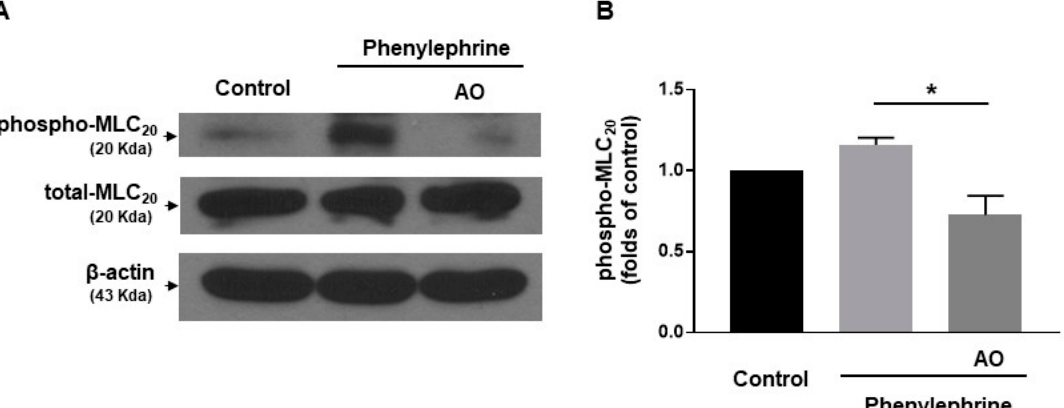
Figure 5. Effect of A. officinarum extract on the phosphorylation of 20 kDa myosin light chain (MLC 20 ). ( A ), representative Western blot analysis for phosphorylated MLC 20 (phospho–MLC 20 ) and total MLC 20 (total–MLC 20 ) in control VSMCs, VSMCs treated with phenylephrine (5 µ M), and VSMCs co-treated with phenylephrine (5 µ M) and A. officinarum (30 µ g/mL). ( B ). Quantitative data for phosphorylated MLC 20 . * p < 0.05 (AO: Alpinia officinarum extract). 2.6. 1,3,3-. Trimethyl-2-Oxabicyclo [2.2.2]octane (Eucalyptol), an Active Compound of A. officinarum Extract, Induced Concentration-Dependent Vasodilation